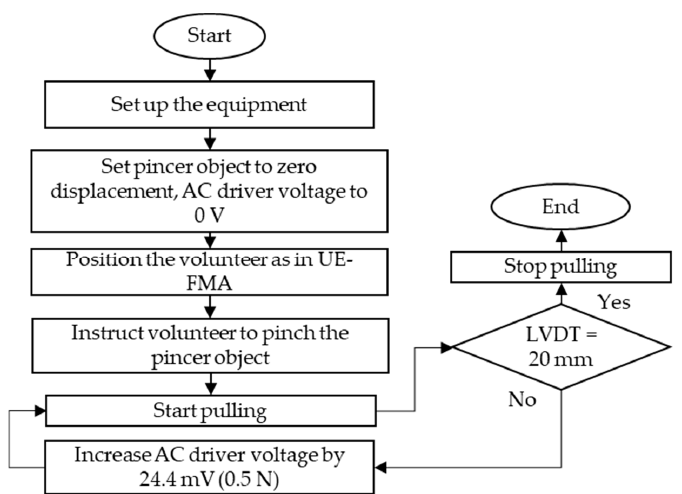
Figure A2. Flowchart of experiment execution.